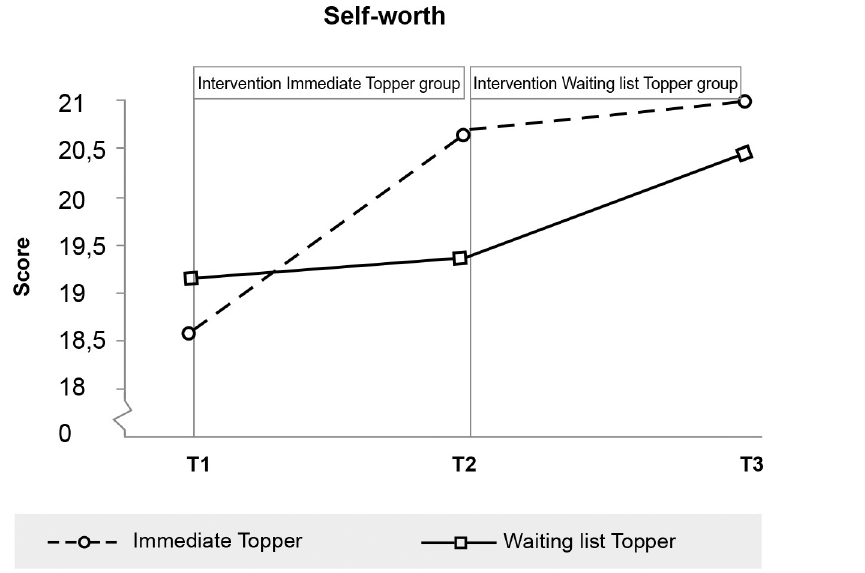
Fig 8. Significant effect of Topper Training on